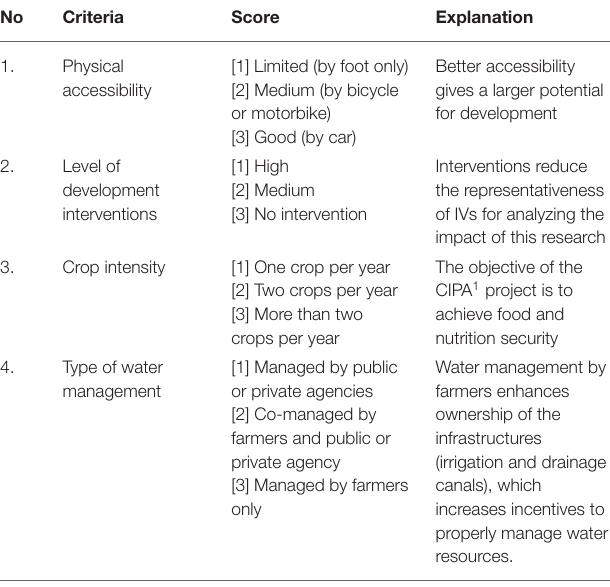
TABLE 2 | Criteria to select inland valleys in Côte d’Ivoire and